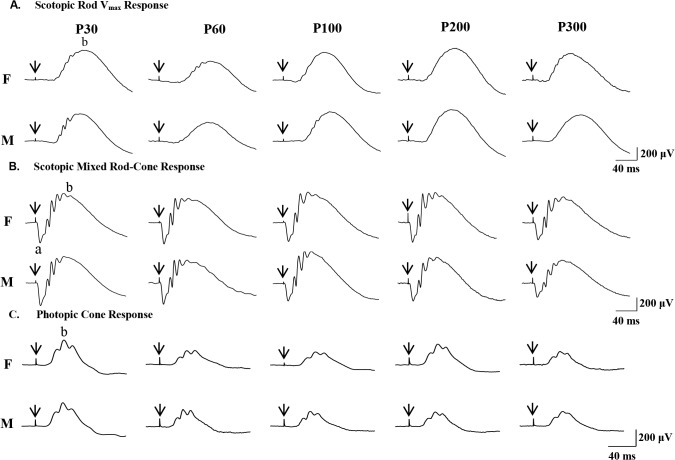
Representative scotopic rod Vmax (A) and mixed rod-cone (B) ERGs and photopic ERG (C) recorded from a male and a female rat aged 30, 60, 100, 200 and 300 days old (age identified as P at the top up each column).Vertical arrows correspond to the stimulus onset. Horizontal calibration: 40 msec. Vertical calibration: 200 μV. Abbreviations: a: a-wave; b: b-wave. F: female rat. M: male rat.